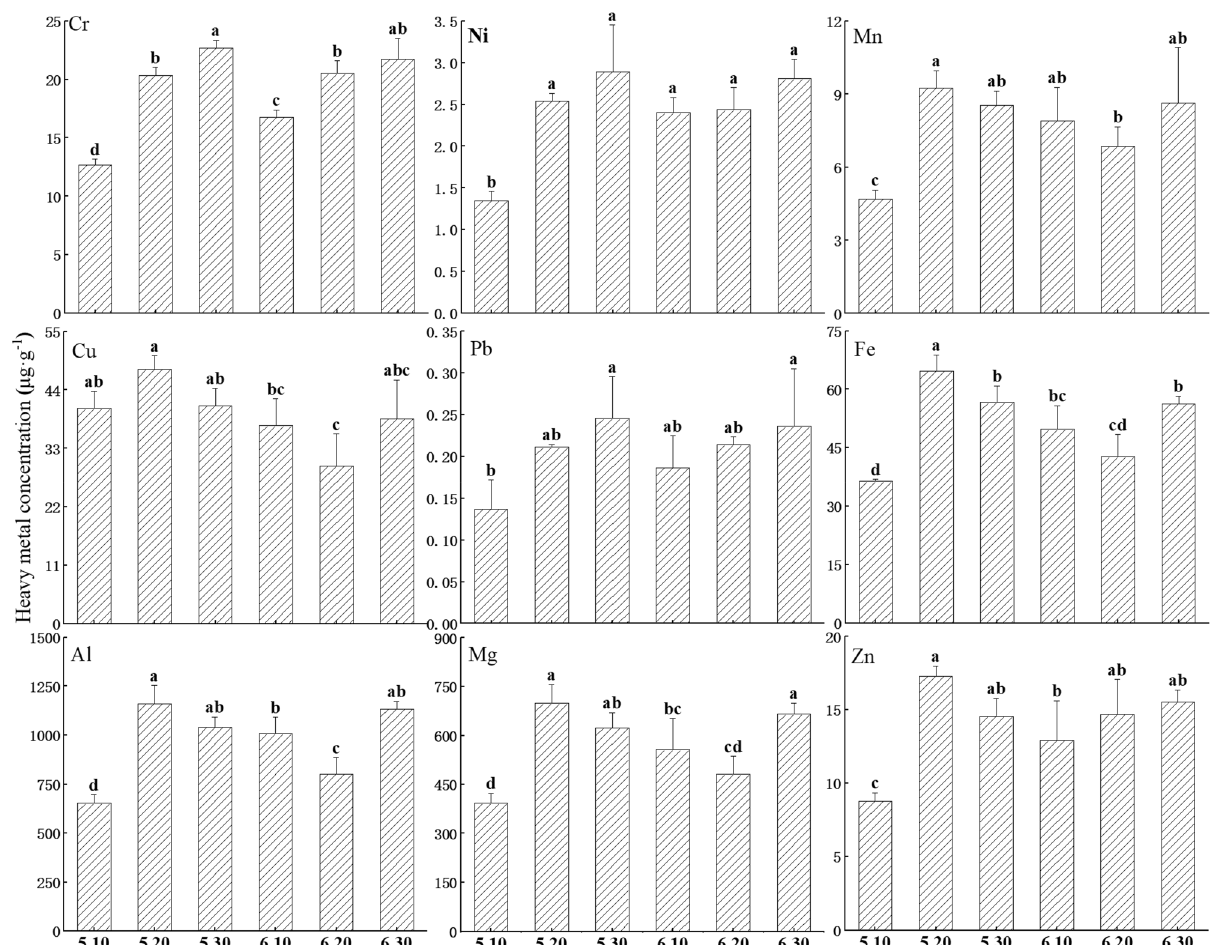
Figure 4. Differences in trace elements in earthworm mucus among electrical stimuli. 5.10, 5.20, 5.30, 6.10, 6.20, 6.30 indicate 5 V 10 mA, 5 V 20 mA, 5 V 30 mA, 6 V 10 mA, 6 V 20 mA, and 6 V 30 mA, respectively. Data are presented as the mean ± SD for three duplicates, n = 3. To test for significance difference between different treatment groups, one-way analysis of variance (ANOVA) was used. Different lowercase letters indicate significant differences of the same index under different electrical stimuli ( P <